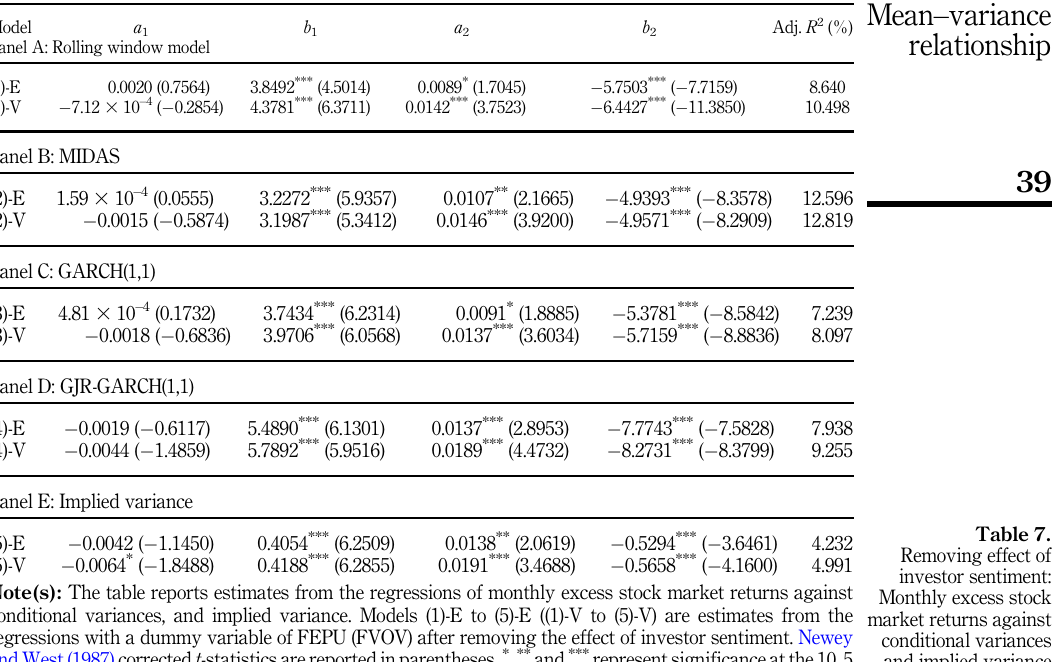
Table 7. Removing effect